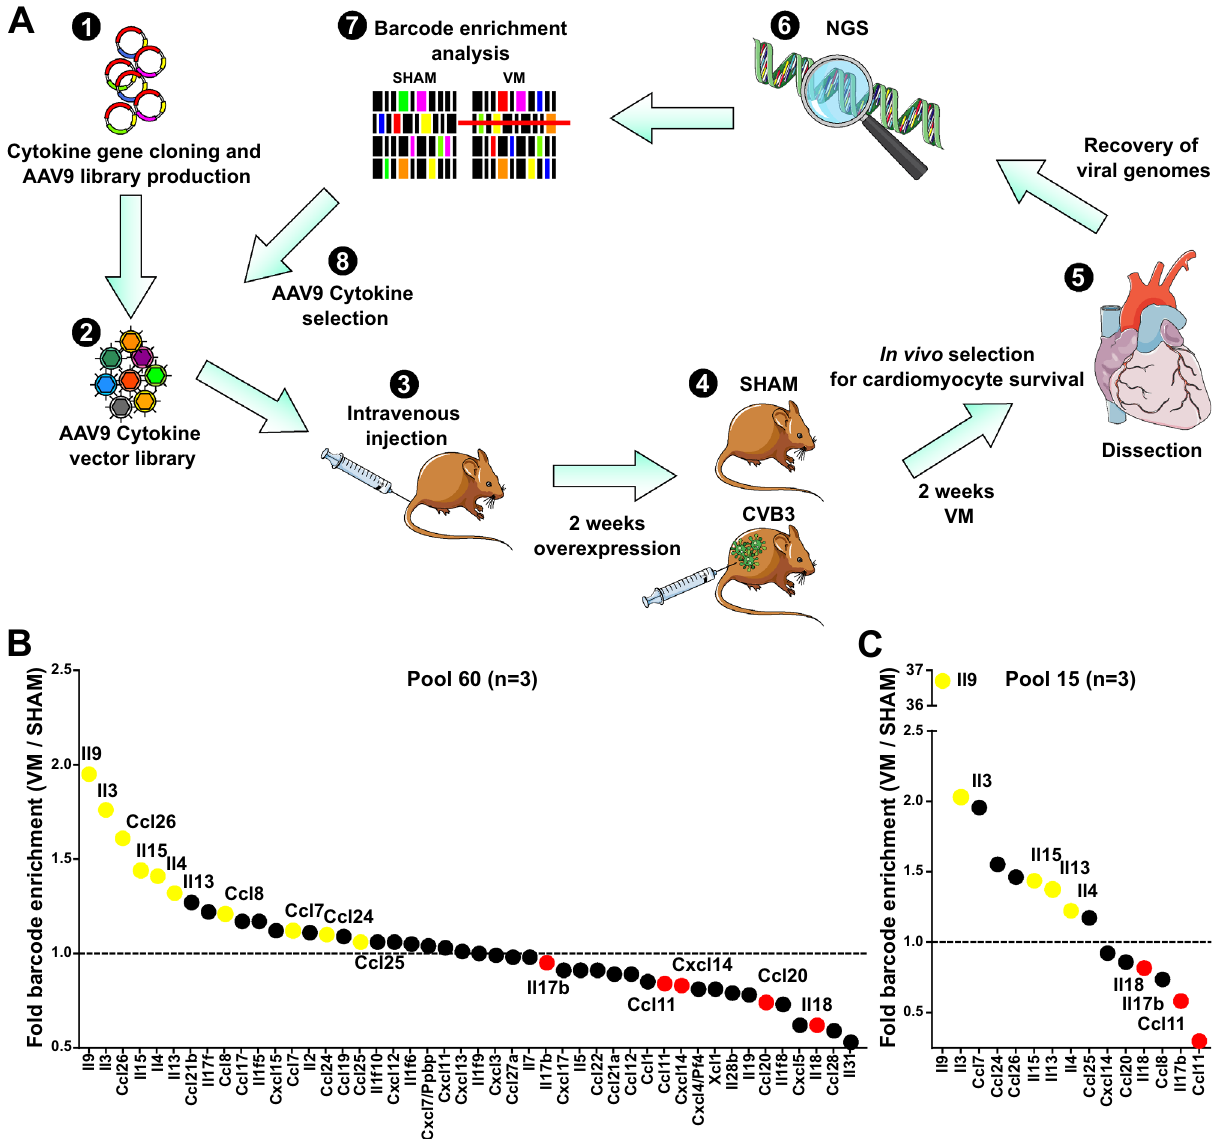
Figure 1. FunSel identifies IL9 as a cardioprotective agent in the sub-acute phase during VM. ( A ) Graphical representation of the events included in the Functional Selection (FunSel) technique to screen potential cardioprotective targets under the selective pressure of viral myocarditis (VM). NGS Next-generation sequencing. B Results of competitive selection of the most efficiently expressed cytokines (46 of the initial 60) in Pool 60. Each dot represents the relative enrichment of each cytokine vector detected by barcode sequencing, 2 weeks after Coxsackievirus B3 (CVB3)-infection (1.00 = no enrichment, dotted line; > 1.00 = positive selection; < 1.00 = negative selection) from pools of 3 animals per group. From this first set of results, 10 enriched cytokines (in yellow) and 5 depleted cytokines (in red) were selected to obtain Pool 15, with which a second FunSel cycle was performed. ( C ) Same as in ( B ) after overexpression of pool 15, 2 weeks after CVB3-infection from biological pools of 3 animals per group. In yellow, cytokines enriched in VM, chosen to study further (IL9, IL3, IL15, IL13, and IL4); in red, cytokines most consistently depleted in both rounds of VM (IL18, IL17b, and